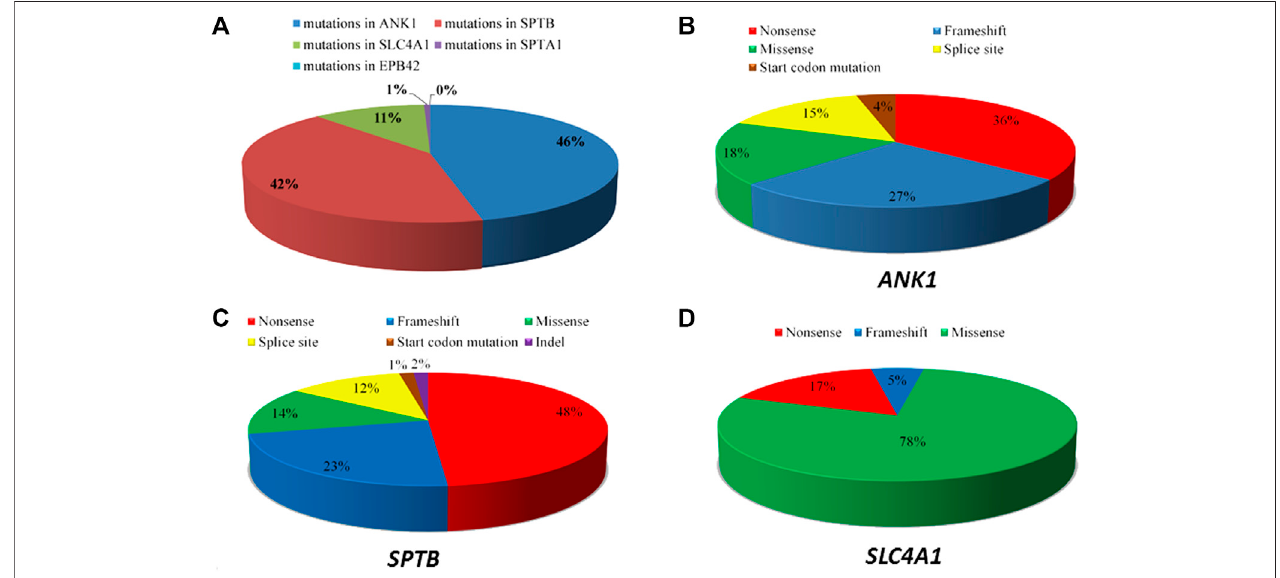
FIGURE 1 | Summary of the causative genes spectrum of Chinese HS patients. (A) The distribution of fi ve causative genes ( ANK1, SPTB, SPTA1, SLC4A1 , and EPB42 ) mutations. (B) Types of ANK1 mutations. (C) Types of SPTB mutations. (D) Types of SLC4A1 mutations.